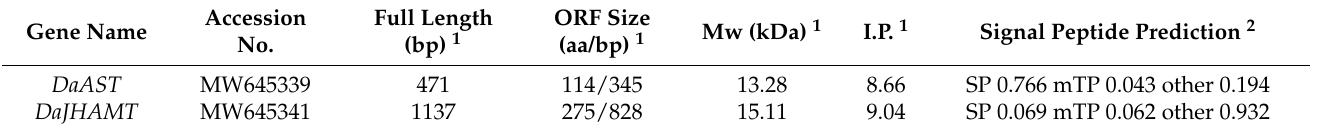
Table 2. Physicochemical properties and cellular localization of DaAST and DaJHAMT of D. armandi